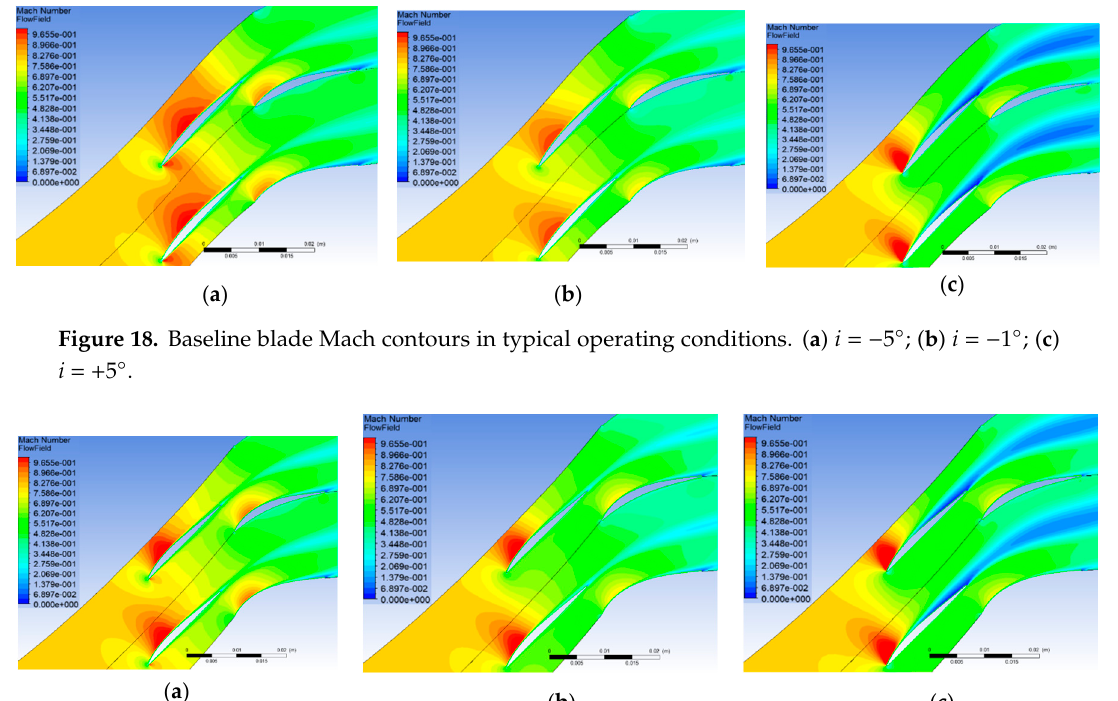
Figure 17. Comparison of baseline and optimized blade performances. ( a ) Incidence—loss coefficient; ( b ) incidence—diffusion factor.